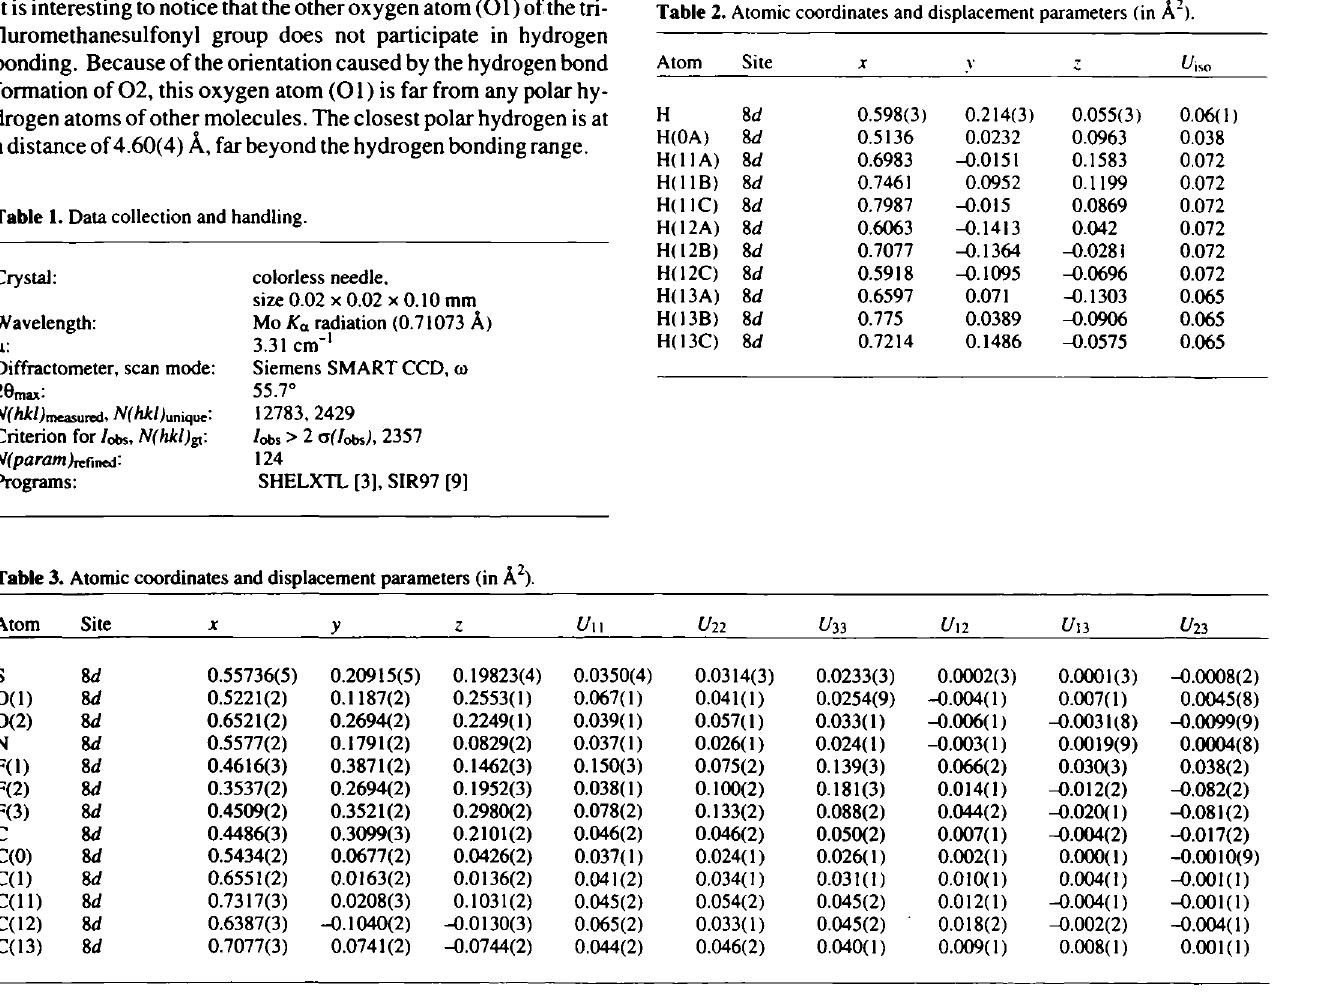
Table 3. Atomic coordinates and displacement parameters (in A 2